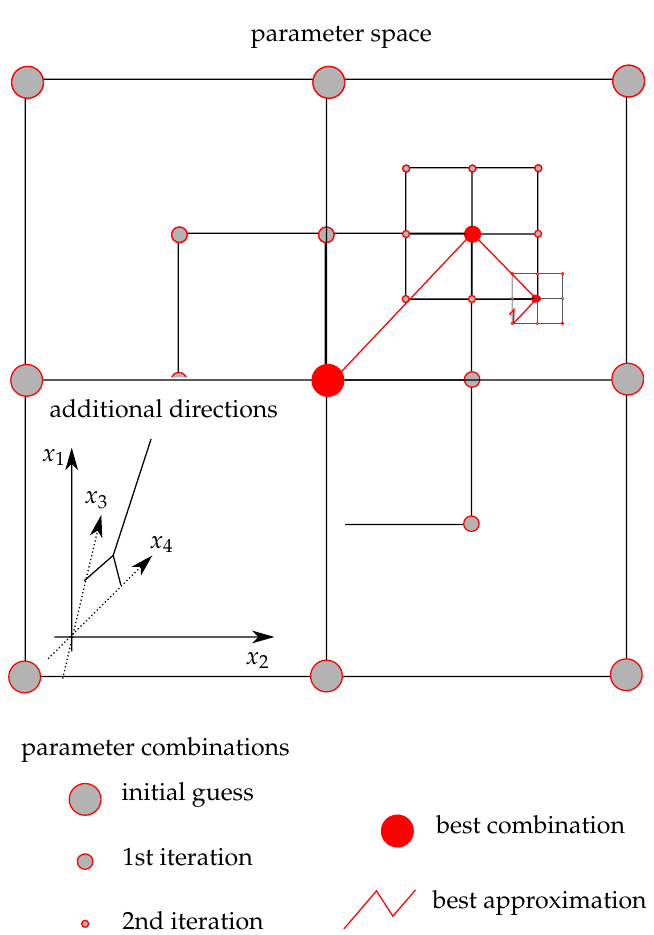
Figure 3. 2D schematic of the hierarchical approach used to approximate parameters quickly in high- dimensional parameter space; each dimension represents one parameter x i ; the algorithm identifies the best fit for the given data (here stress–strain pairs from material tests) (published in